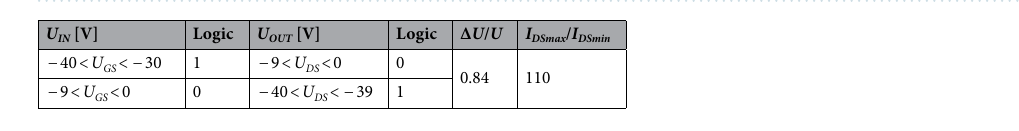
Table 1. Truth table for the modeled